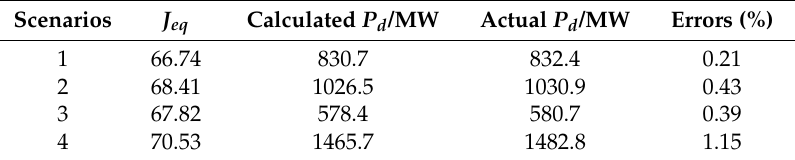
Table 2. Power deficit calculation errors of the proposed strategy in different scenarios.